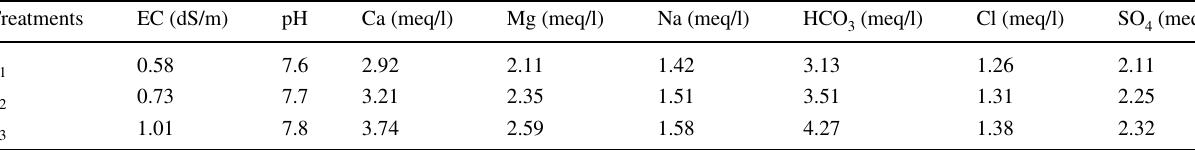
Table 1 The chemical characteristics of irrigation water for different treatments Treatments